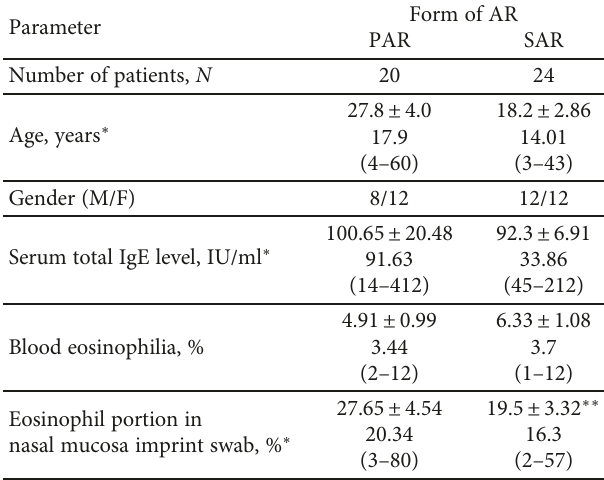
Table 2: Characteristics of patients with allergic